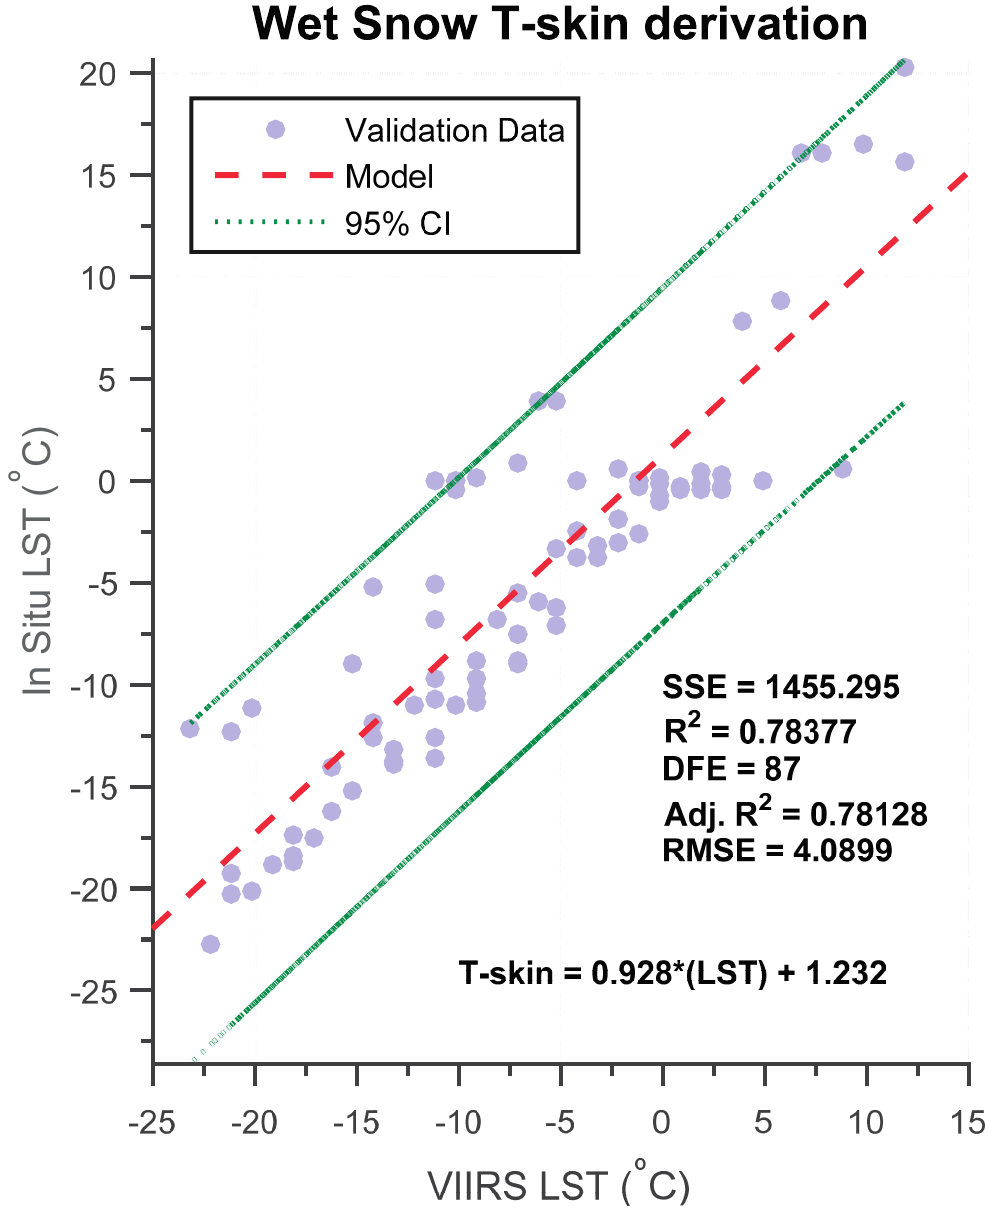
Figure 12. T-skin derived empirical formula based on linear regression model between clear-sky VIIRS LST daytime (wet snow) views with respective in situ temperatures at